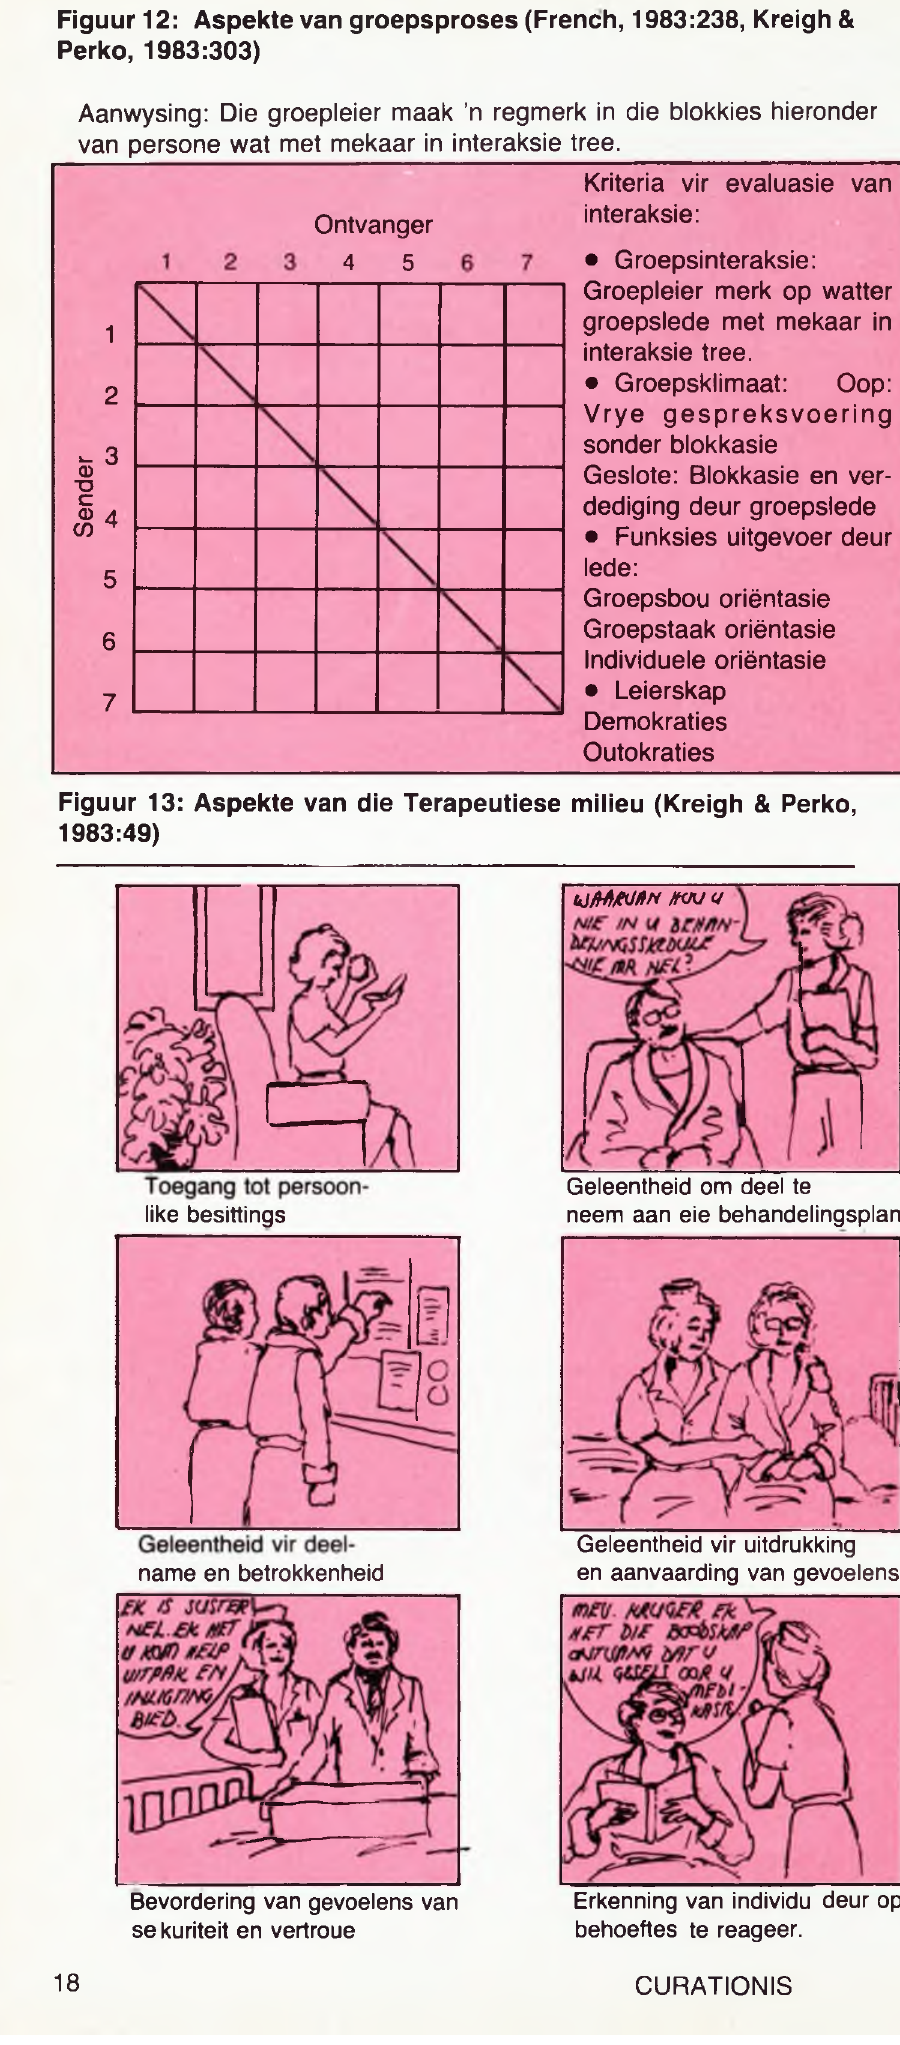
Figuur 12: Aspekte van groepsproses (French, 1983:238, Kreigh & Perko, 1983:303) Aanwysing: Die groepleier maak ’n regmerk in die blokkies hieronder